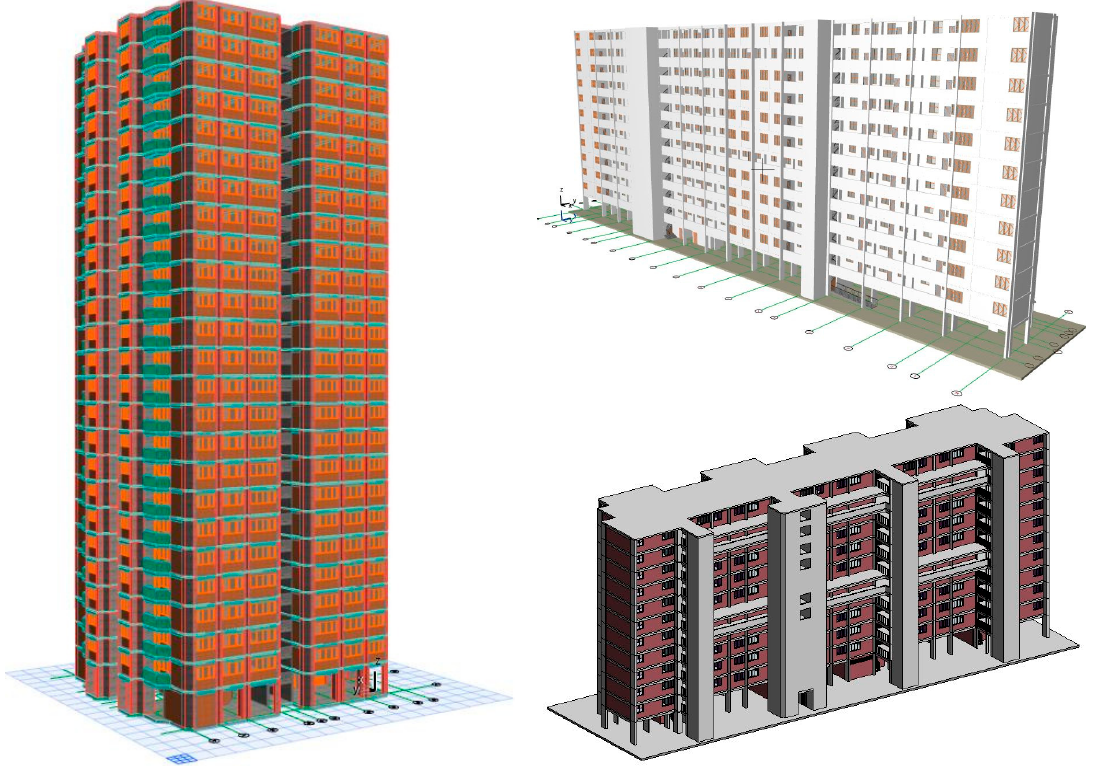
Figure 2. “Point” block apartment Archicad Model ( left ), “Slab” block apartment Archicad model ( upper right ) and “Slab” block apartment Revit Model ( lower right ).